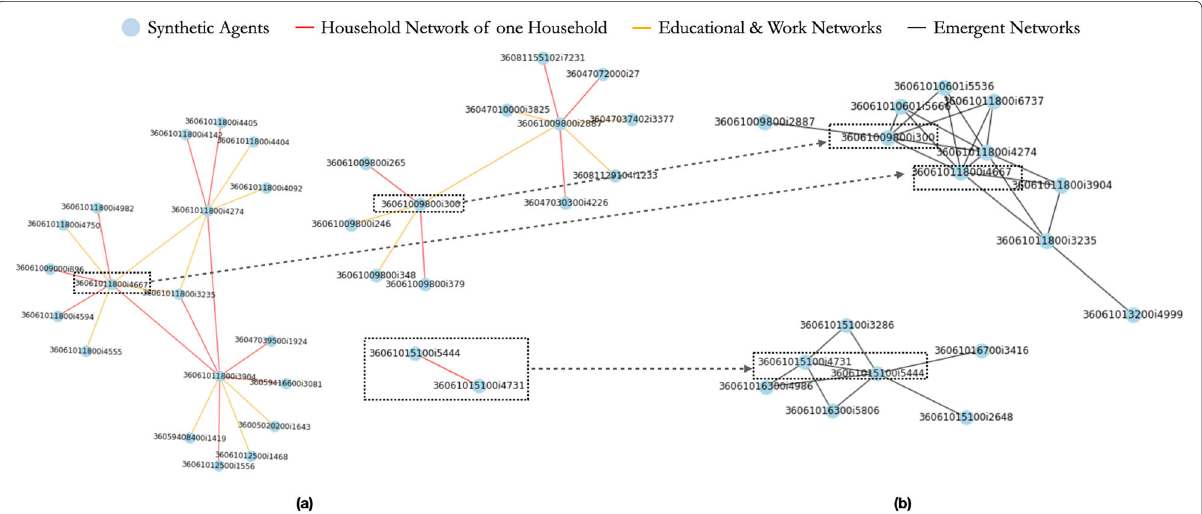
Fig. 14 Simulation of Social Networks Changes for a Sample of the Population: ( a ) Before the Disaster Event; ( b ) Emergent Social Networks After the Disaster